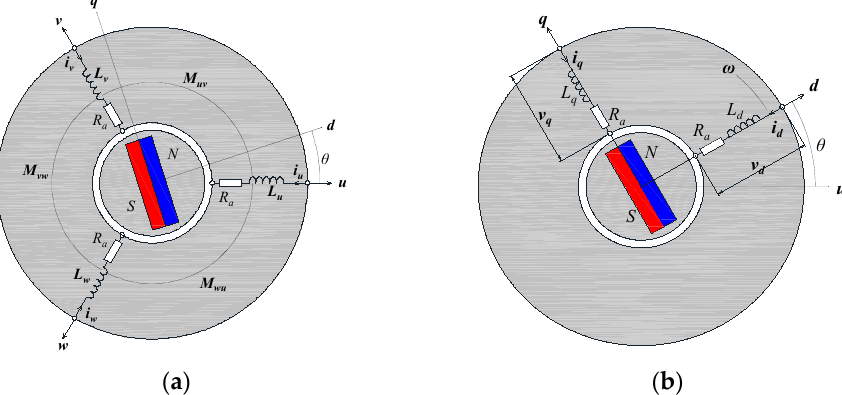
Figure 15. Basic model of PMSG with two poles: ( a ) 3-phase model, and ( b ) transformed dq model.